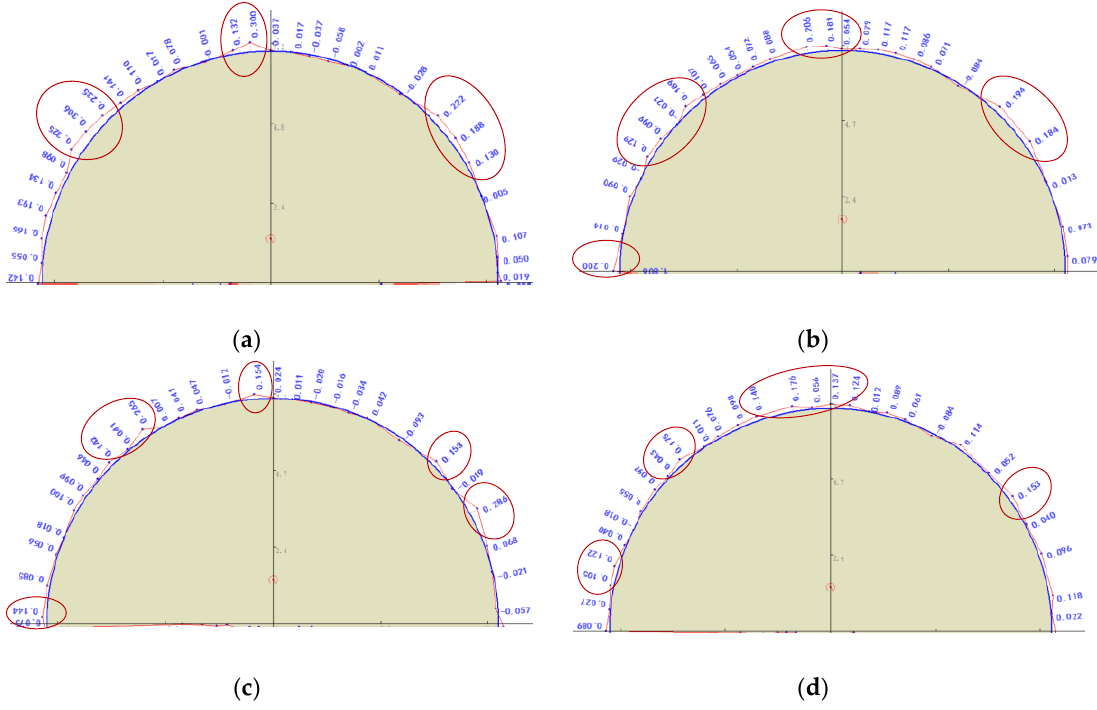
Figure 15. Section profiles measured from the Zigaojian Tunnel site. ( a ) Close to the tunnel face, ( b ) 1.5 m in front of the tunnel face, ( c ) 3 m in front of the tunnel face, and ( d ) 4.5 m in front of the tunnel face.